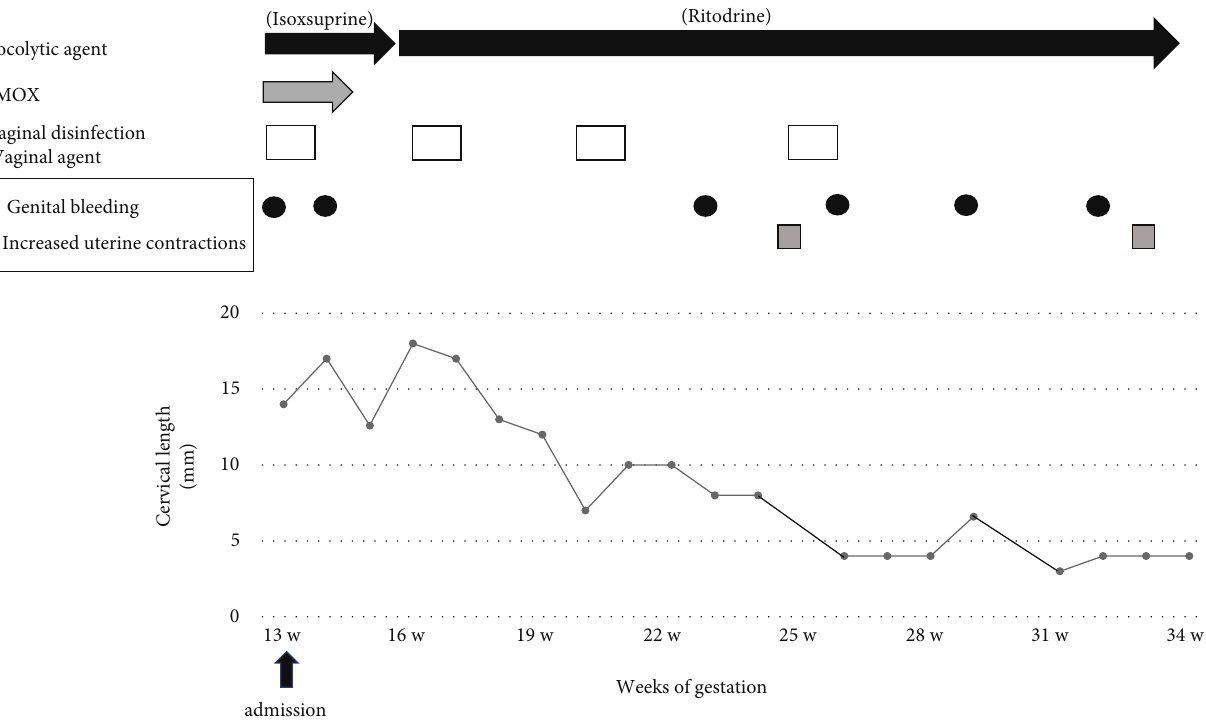
Figure 2: A diagram showing the clinical course of the patient. The cervical length decreased with a small amount of genital bleeding as gestation progressed. FMOX, fl